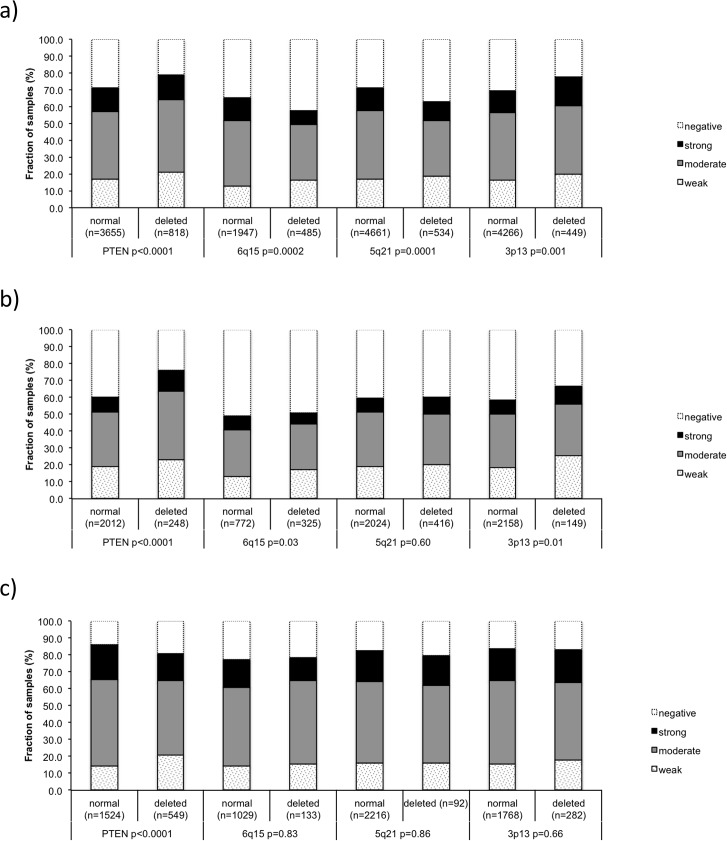
SOX9 expression versus PTEN, 3p13, 6q15 and 5q21 deletions probed by FISH analysis.(a) all cancers, (b) in ERG-negative, c) ERG-positive subset.